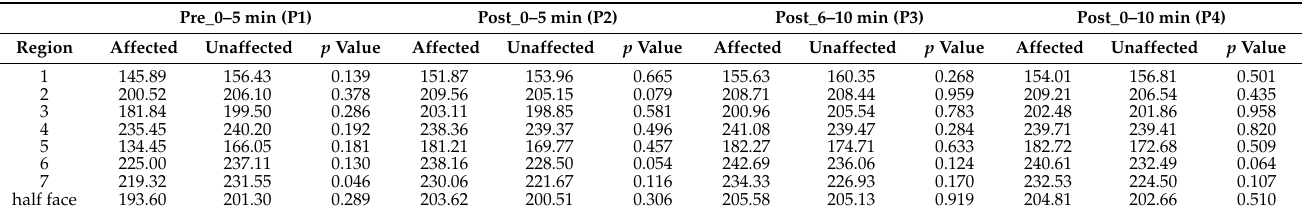
Table 3 shows the facial skin blood flow before and after a single PMS intervention in stroke patients with FP. Before the intervention, the SkBF on the affected face (both on the half face and seven regions) of all patients was lower than that on the healthy side. After the intervention, the SkBF on the affected face (both on the half-face and seven regions) in stroke patients all increased and it even exceeded that of the unaffected side in some areas (half face, Region 2, Region 3, Region 4, Region 5, Region 6, Region 7). There was no statistical difference between the affected and unaffected sides after the PMS intervention, but it shows a trend. For the affected and unaffected half face, the facial skin blood flow changed from 193.60 (P1) to 203.62 (P2) and 205.58 (P3) on the affected face, and from 201.30 (P1) to 200.51 (P2) and 205.13 (P3) on the unaffected face. Table 3. The facial skin blood flow between the affected and unaffected faces in stroke patients with facial paralysis.